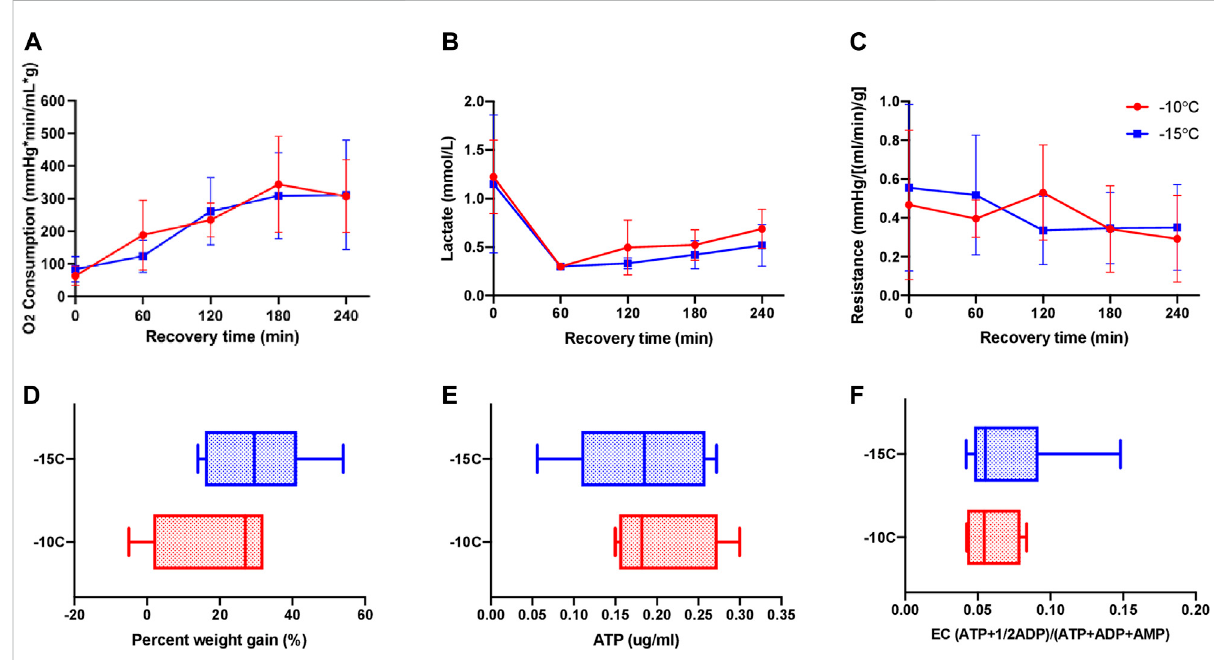
FIGURE 2 Perfusionmetricscomparingpartiallyfrozenratliversstoredfor1( n =6)and5( n =7)daysat – 10 ° C( n =4)vs. – 15 ° C( n =9)with12%glyceroland 4 h of recovery during SNMP revealed no functional differences between the groups. (A) Oxygen consumption, de fi ned as out fl ow oxygen minus in fl owoxygen,adjustedfor fl owrateandliverweight, (B) in fl owlactate, (C) resistance, de fi nedastheperfusionpressureinthePVdividedbythe fl ow rate and adjusted for liver weight after procurement, (D) percent weight gain, de fi ned as percentage increase of liver weight at the end of recovery compared to liver weight after procurement, (E) ATP, (F) energy charge. Two-way ANOVA, followed by Tukey ’ s post hoc test for (A – C) . Unpaired two-tailed t -test for (D – F) . Boxes: median with interquartile range. Whiskers: min to max. Signi fi cance level: p <